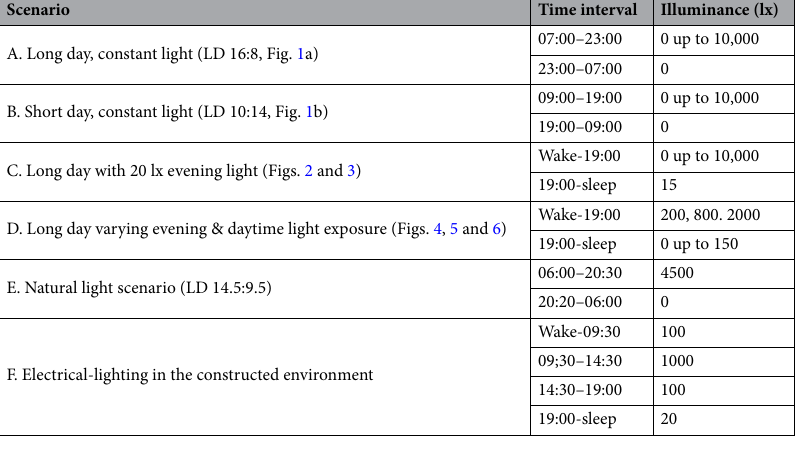
Table 2. Simulated light